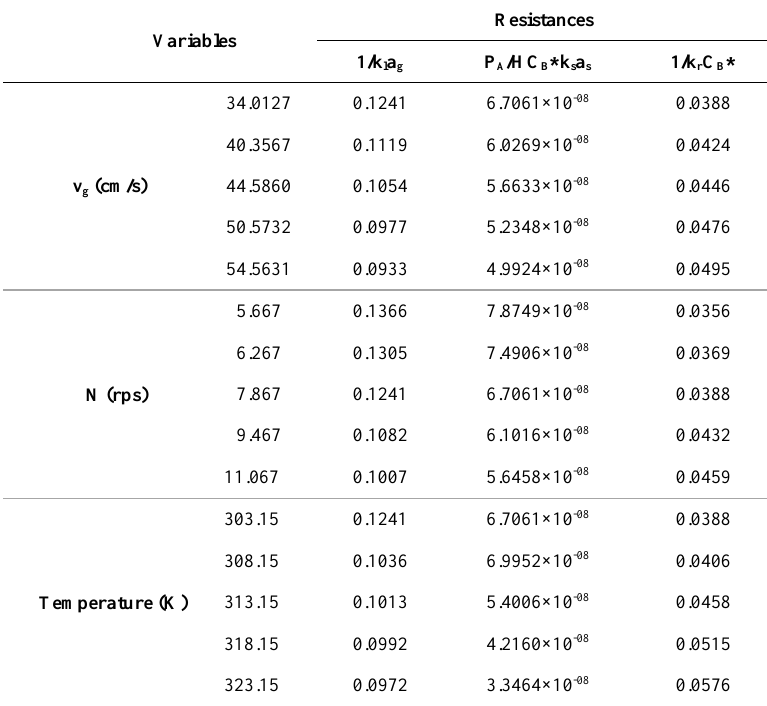
Table 2. Resistances which affect